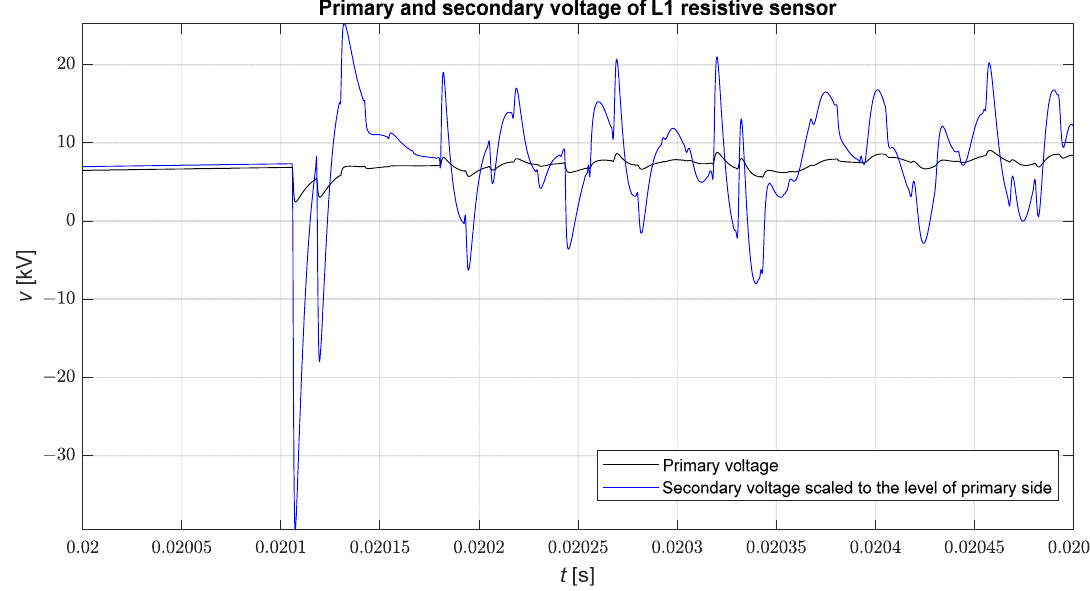
Figure 8. Comparison of the phase voltage waveform ( 𝑣 (cid:2896)(cid:2869) ) and the voltage at the output of the sensor scaled to the primary voltage ( 𝑣 (cid:2896)(cid:2869) /𝐾 (cid:2924) ) during